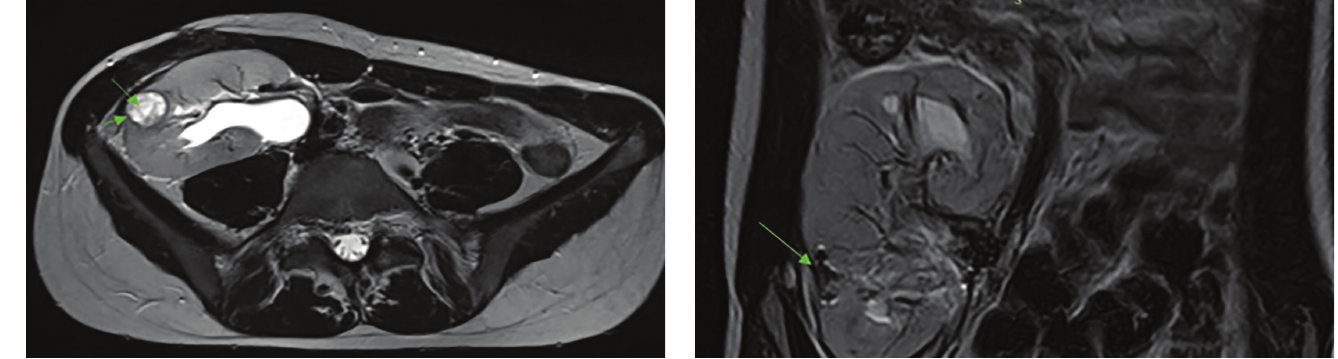
Figure 3 - MRI image 4 years after radiofrequency ablation. Post-ablative tissue changes absence of cystic